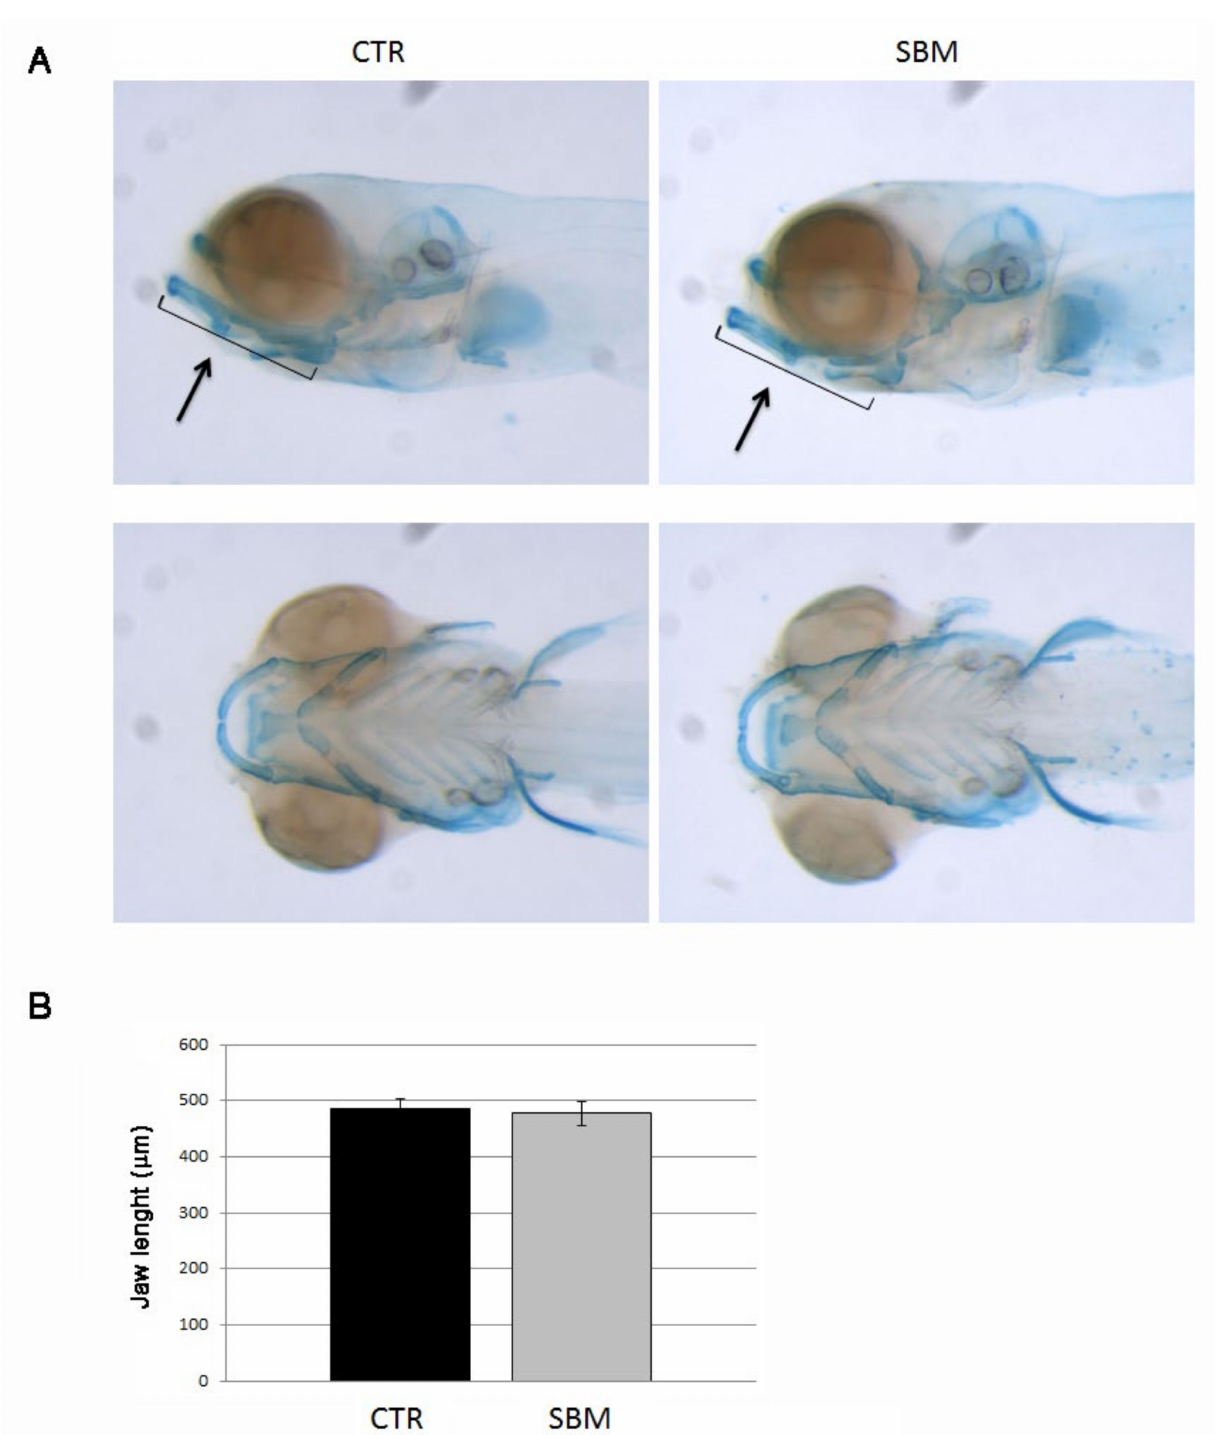
Figure 2. Head of zebrafish embryos stained with alcian blue. ( A ) Cartilage structures of CTR and SBM embryos visualized as lateral view (upper panel) and bottom view (lower panel). Black arrow indicates the jaw. ( B ) Length of jaw in CTR and SBM embryos. The measure was performed as indicated by black arrow in upper panel of A. Data derived from 10 CTR and 10 SBM larvae, with tests performed 3 times as independent experiments with comparable results. No significant difference was detected using the Student t